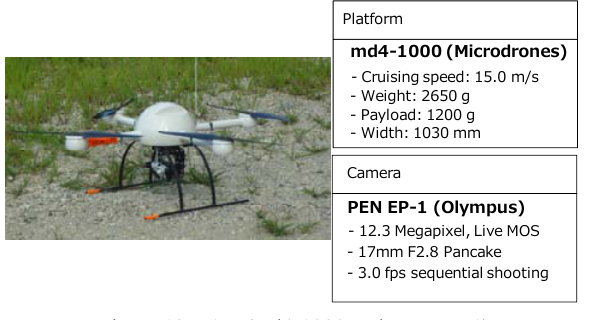
Figure 13.UAV (md4-1000 and PEN EP-1)